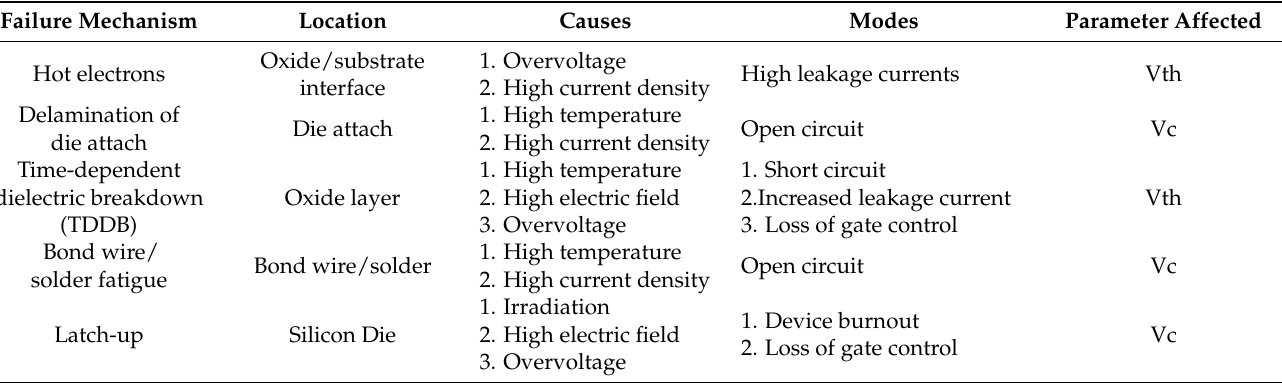
Table 2. Comparison Between Failure